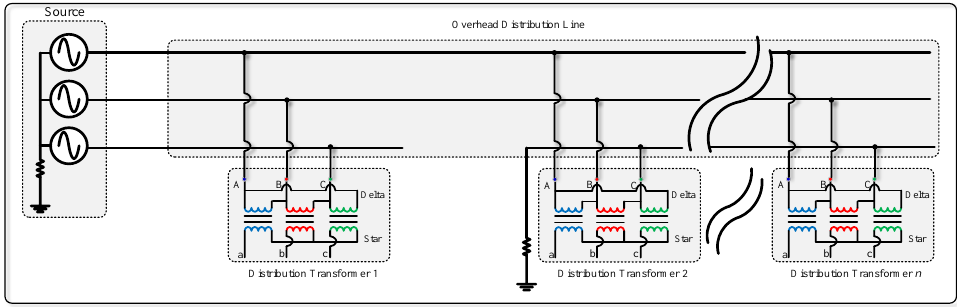
Figure 3. The back-feed from distribution transformers in load side broken conductor fault.